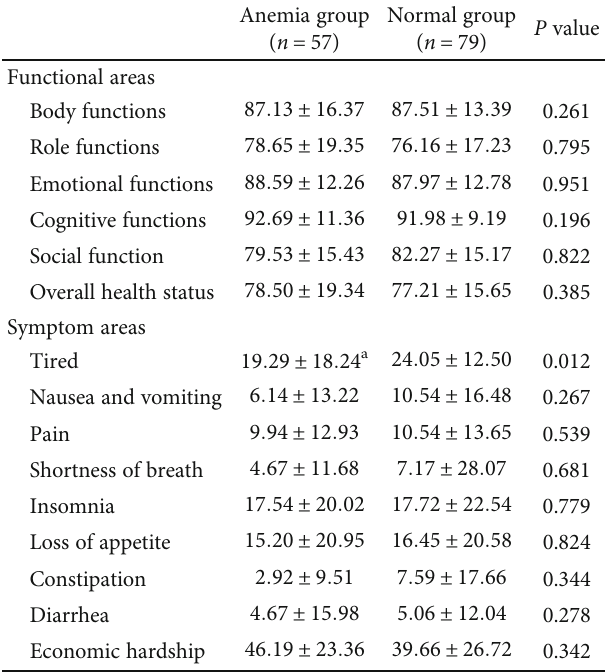
Table 5: EORCT QLQ-C30 scores between anemia group and normal group patients at 3 months after